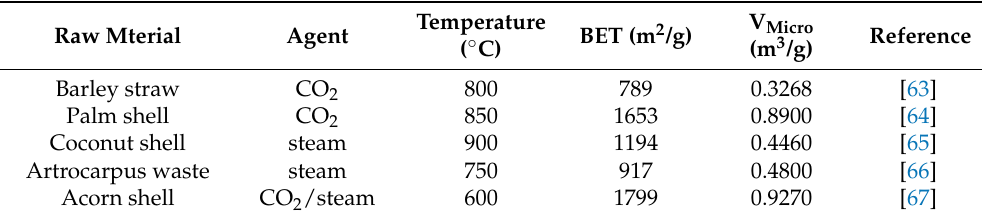
Table 3. Physical activation of various biowaste. Adapted with permission from Ref. [61]. 2019, Ayinla, R.T. and